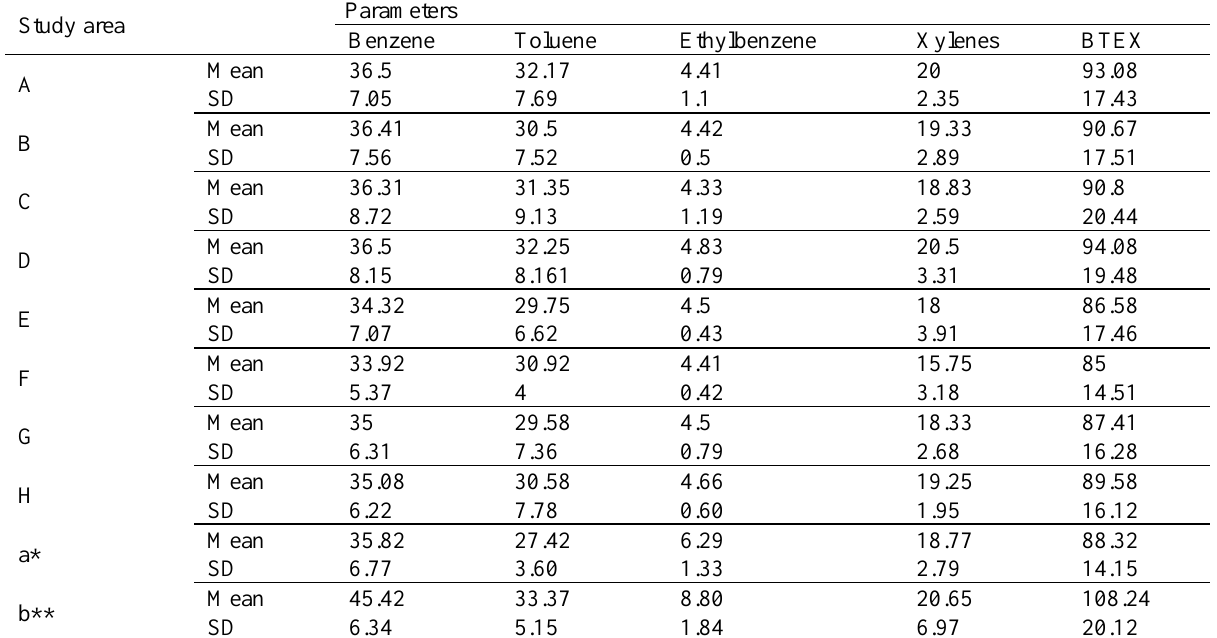
Table 4. Mean changes in concentrations of BTEX (benzene, toluene, ethylbenzene, and xylene) pollutants at Tizro grease oil re-refining plant of Garmsar (µg/m 3 ) Parameters Study area